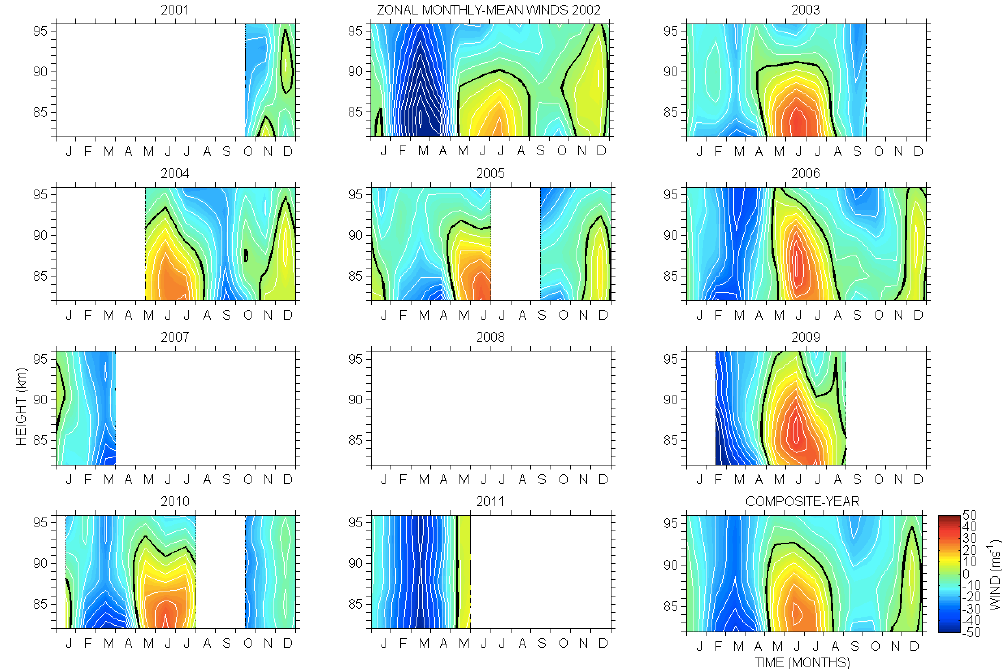
Fig. 4. Monthly-mean zonal winds over Ascension Island for the years 2001 – 2011 and a composite-year. The zero wind contour is indicated in black and the white contours are in steps of 5 m s − 1 .